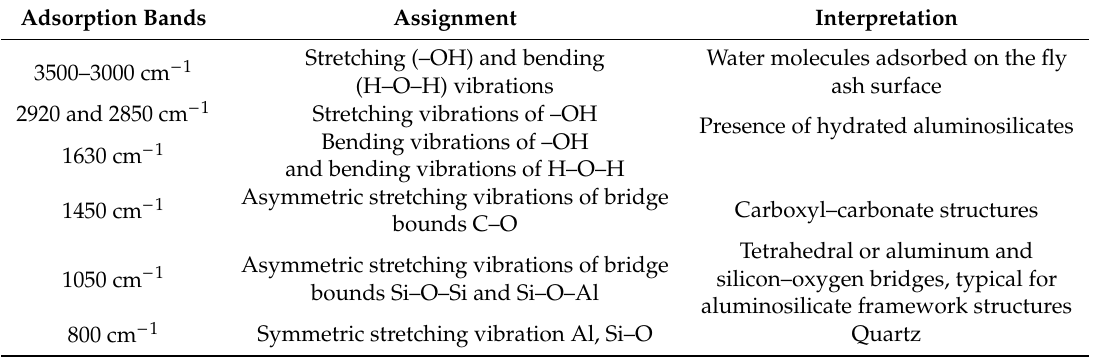
Table 1. The vibration bands of Fourier transform infrared (FT-IR) spectra [15,41–43].